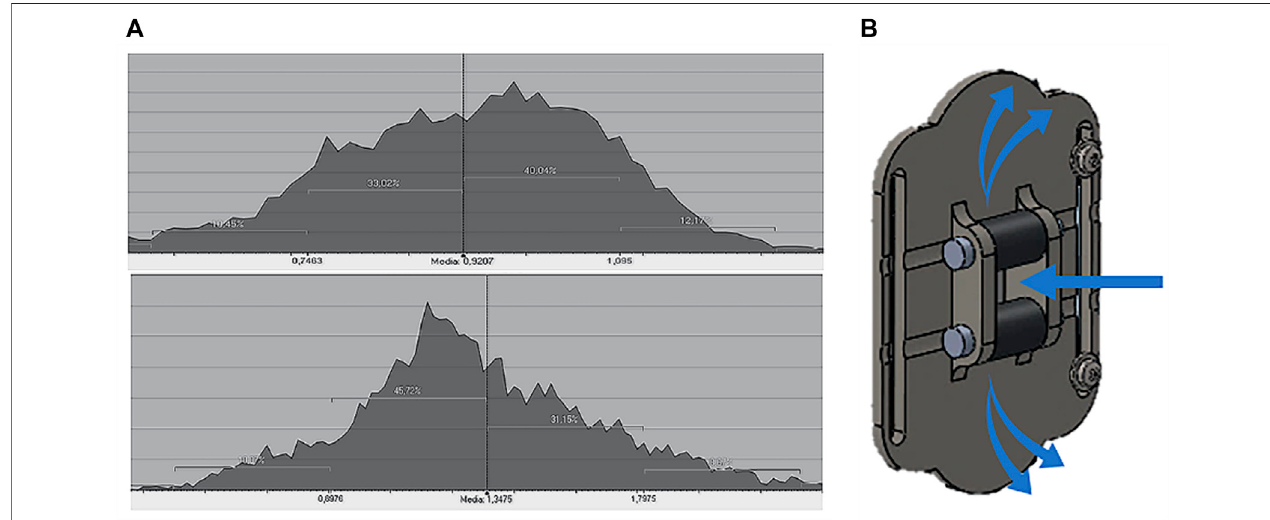
FIGURE 10 | (A) Mesh deviation histogram: test on silicone skin and healthy skin; (B) leakage effect between idle rollers and “ roller seat ” component.